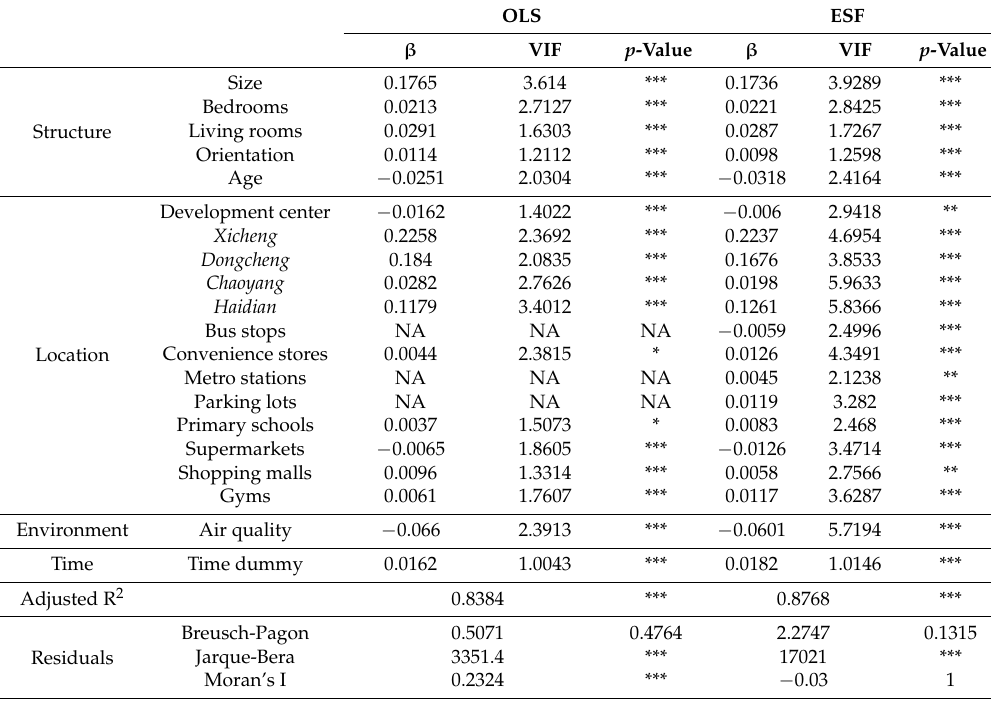
Table 3. Regression analysis results of housing price determinants utilizing OLS and ESF.